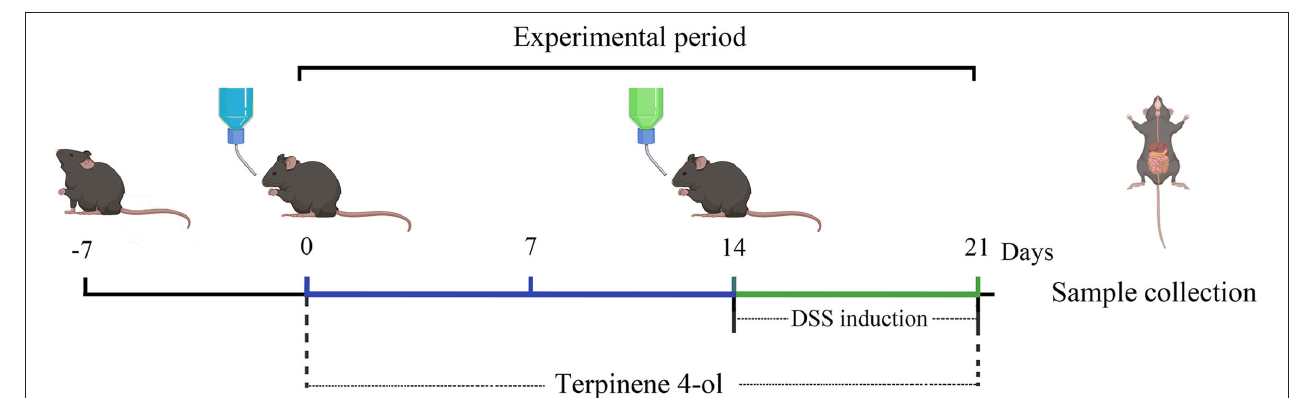
FIGURE 1 | Experimental design demonstrating the effect of terpinen-4-ol (TER) on ameliorating colitis.